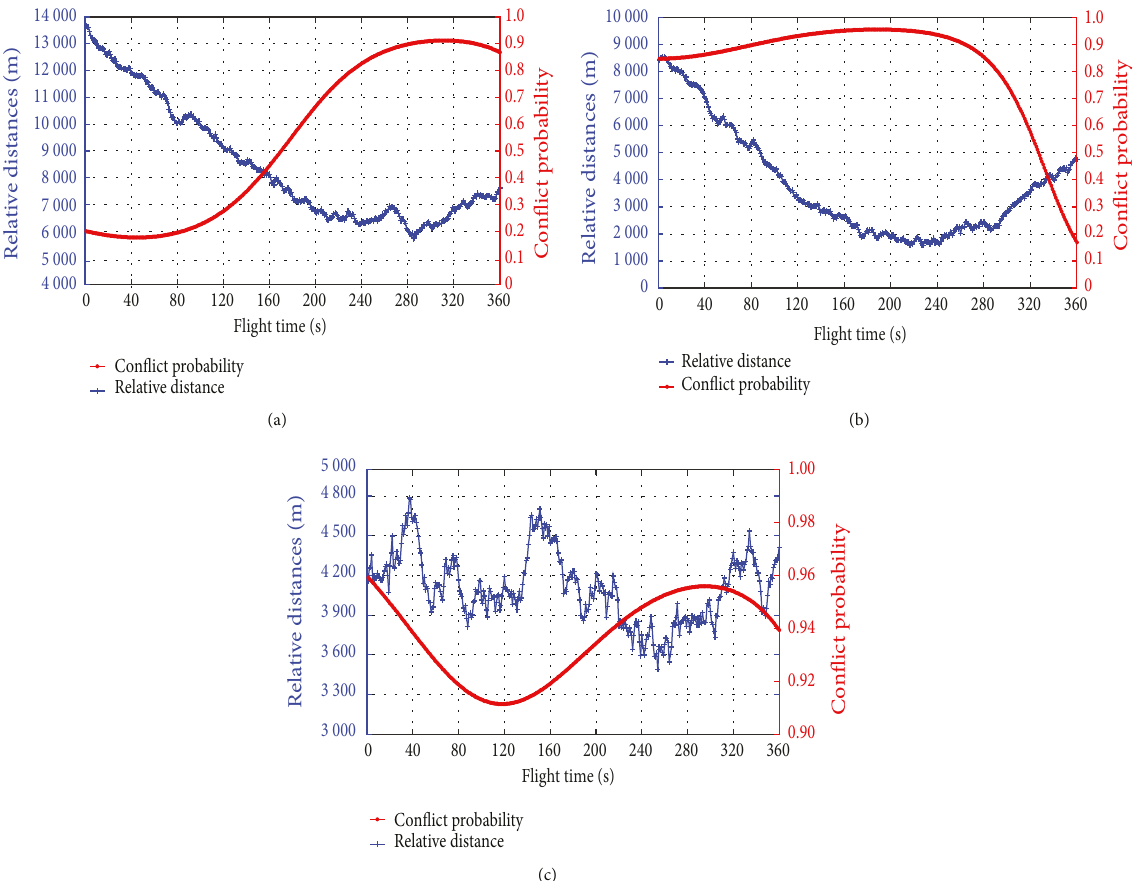
Figure 9: Flighttime-distances/conflictprobability relationship: (a) in approach to landing phase, (b) in intersectionflight,and (c) in parallel